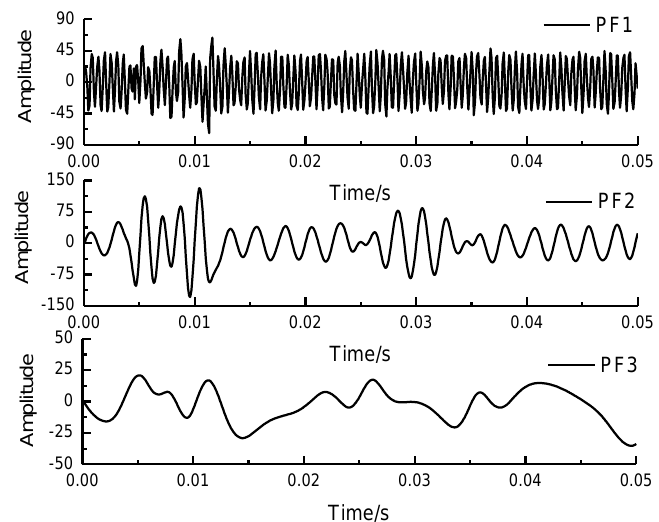
Figure 5. Local mean decomposition (LMD) results of simulation signal y ( t ) .